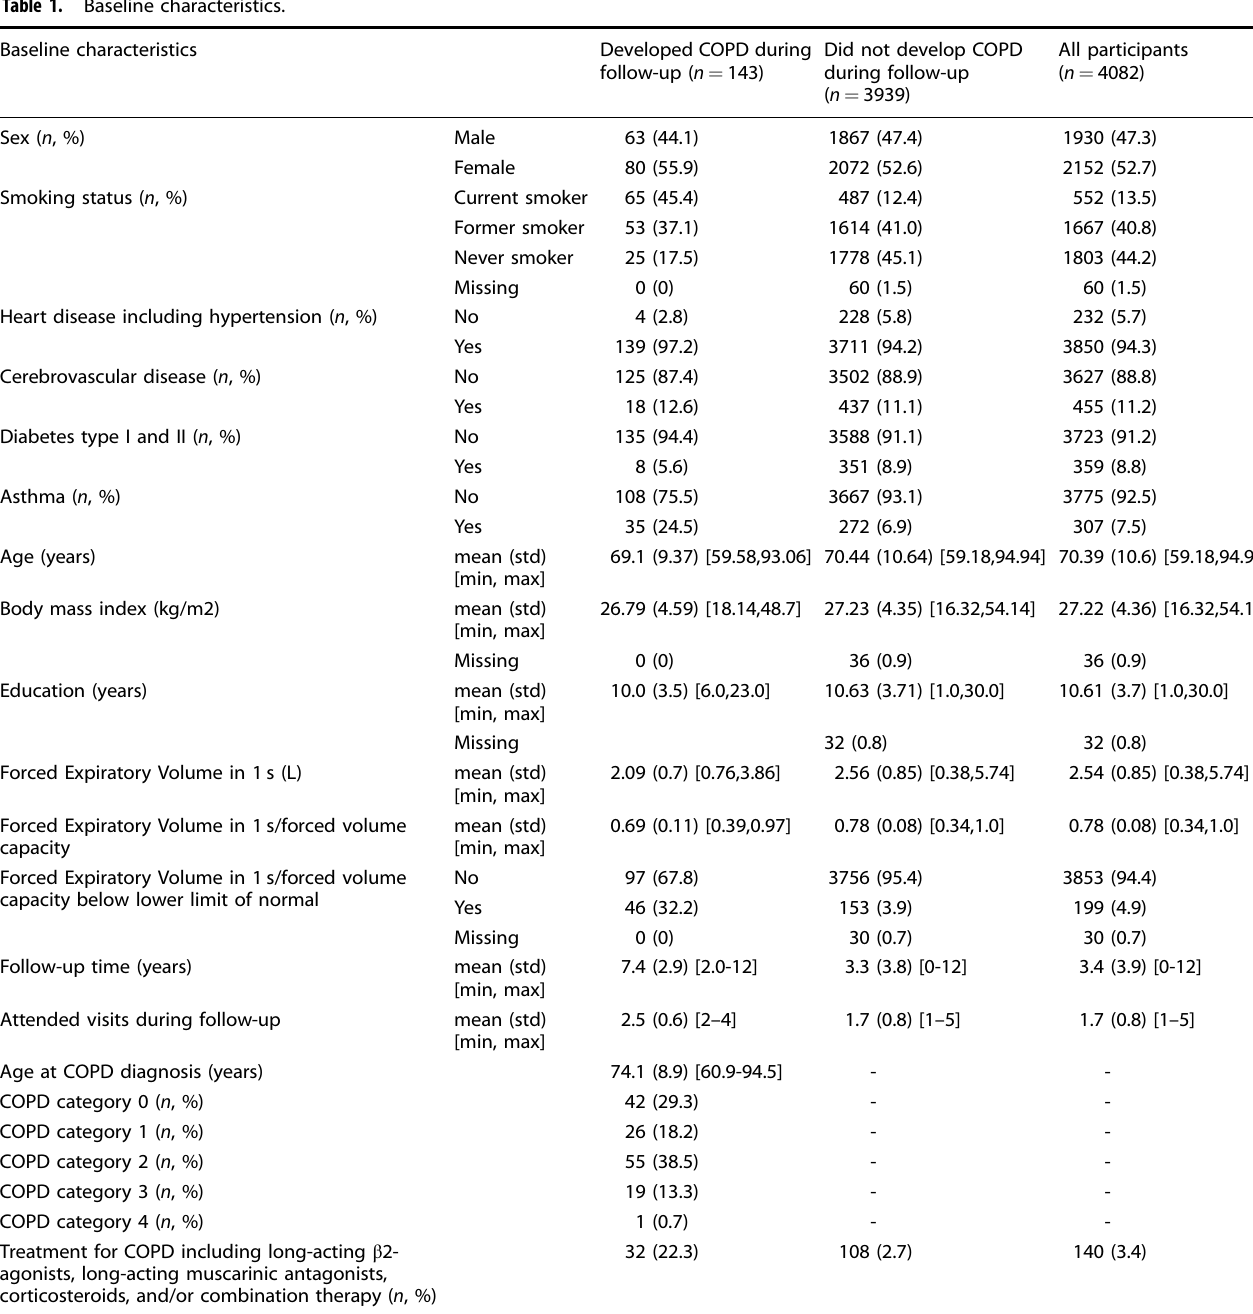
Table 1. Baseline